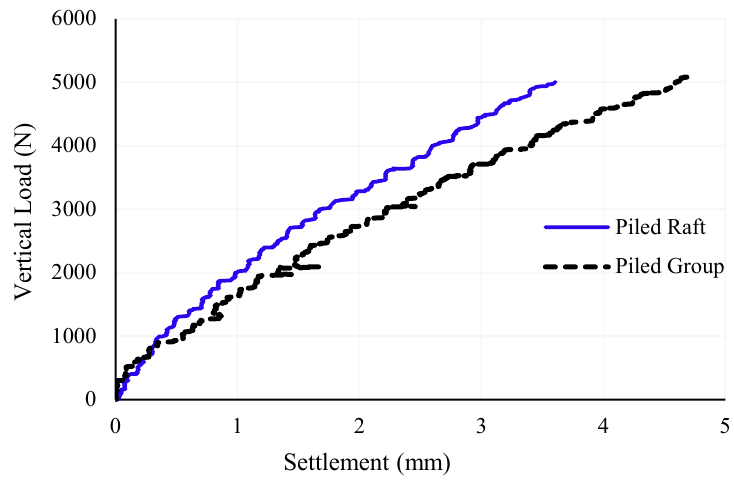
Figure 20. 25-pile group vs. 25-piled raft vertical response.